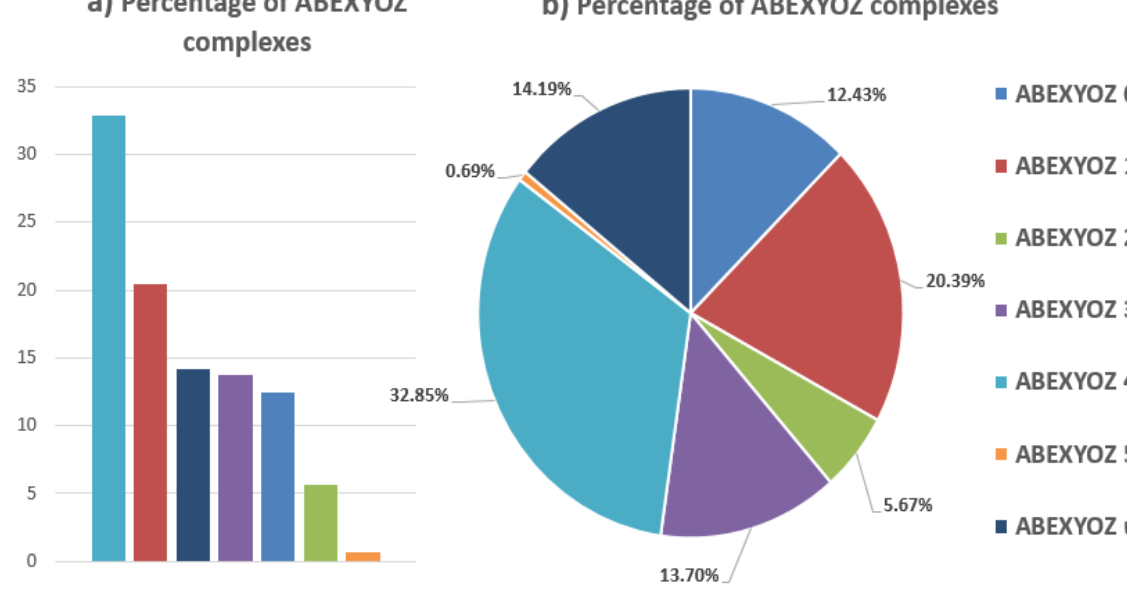
Fig. 5: Distribution of ABEXYOZ complexes with different morphologies. a) Order of percentages of ABEXYOZ complexes, from the most to the least abundant. b) Percentage of ABEXYOZ